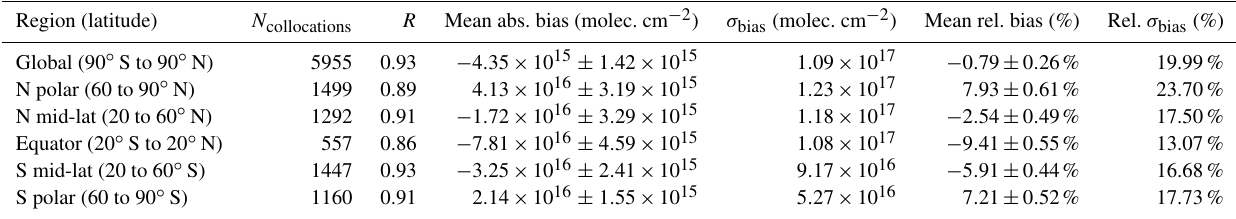
Figure 2. Correlation plots of collocated ACE-FTS and TROPOMI partial columns in the following latitude bands: (a) global (90 ◦ S to 90 ◦ N), (b) N polar (60 to 90 ◦ N), (c) northern mid-latitudes (20 to 60 ◦ N), (d) equatorial (20 ◦ S to 20 ◦ N), (e) southern mid-latitudes (20 to 60 ◦ S), and (f) S polar (60 to 90 ◦ S). In panel (a) , the colour of the data points corresponds to the respective latitude regions. Values of the Pearson correlation coefficient R , the standard deviation of the TROPOMI columns σ , and the mean bias µ of the respective latitude band are displayed in the lower right of panels (a–f) . Table 3. Summary of the number of collocations, the mean partial column differences, and the standard deviations of the differences between ACE-FTS and TROPOMI globally and in each latitude region. The relative bias and standard deviation values are computed with respect to ACE-FTS (i.e., 100 × ( TROPOMI − ACE − FTS )/ ACE − FTS ) . The uncertainties provided for the absolute and relative biases are the standard errors of the